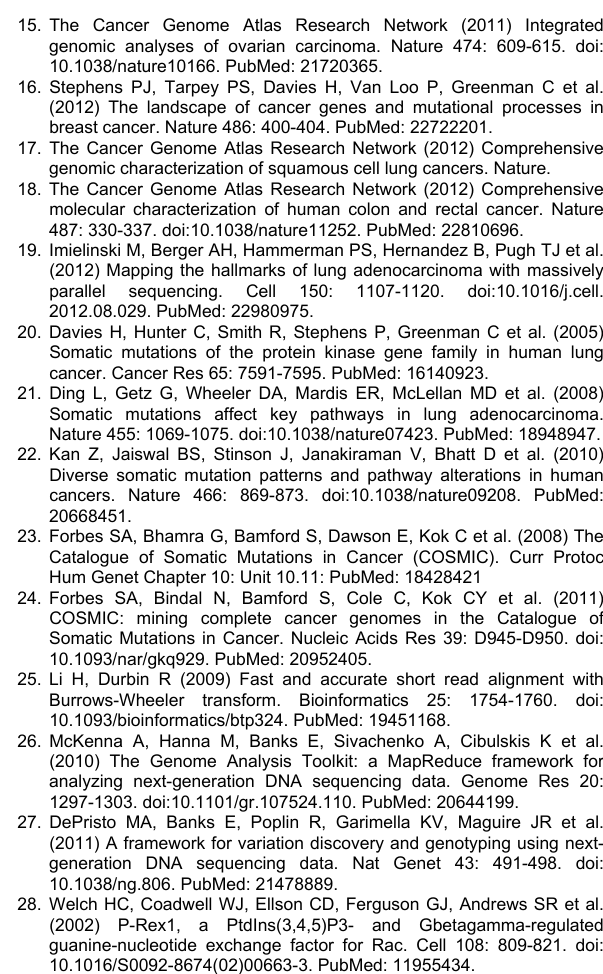
Table S2. The list of somatic mutations identified from the refined dataset. All mutations described in this table are somatic and non-synonymous